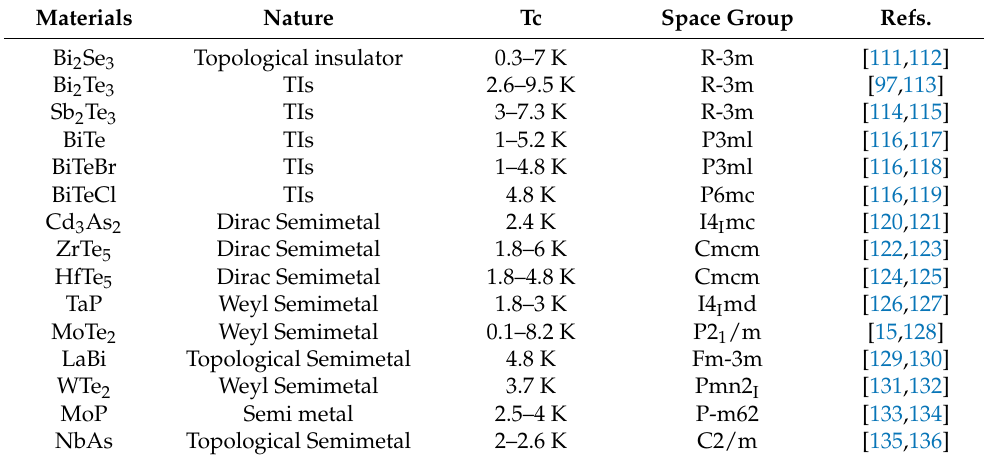
Table 3. List of Topological